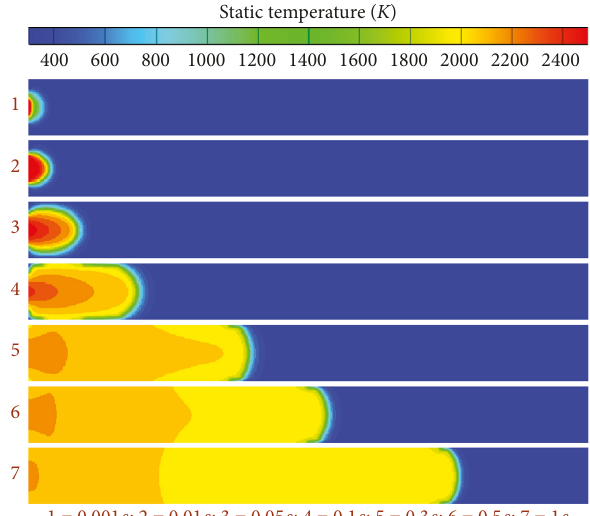
Figure 6: Flame propagation characteristics of deflagration at the initial stage.